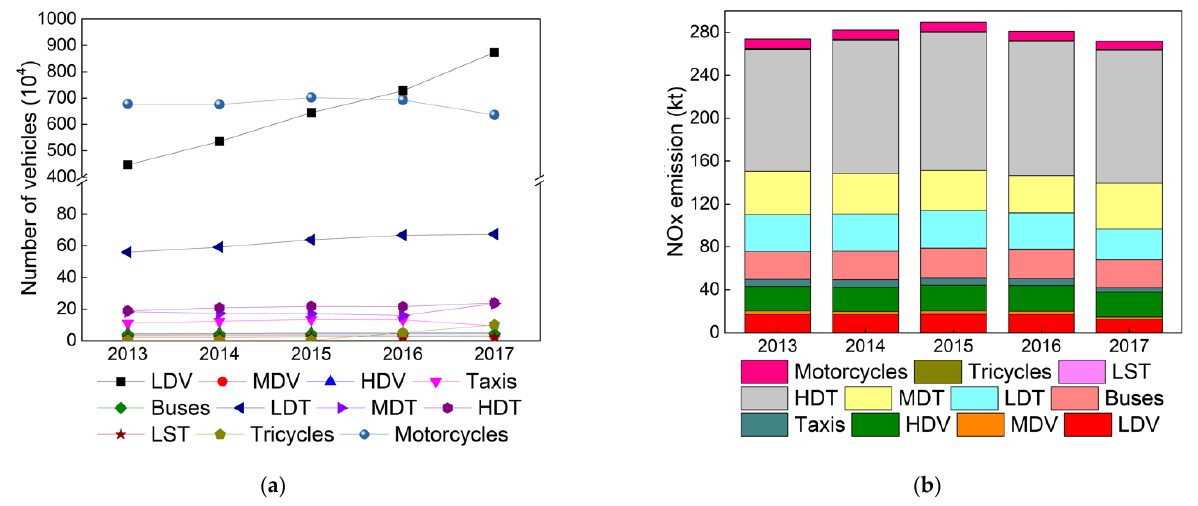
Figure 8. Trends in ( a ) number of vehicles; ( b ) NO X emission from vehicle sources.